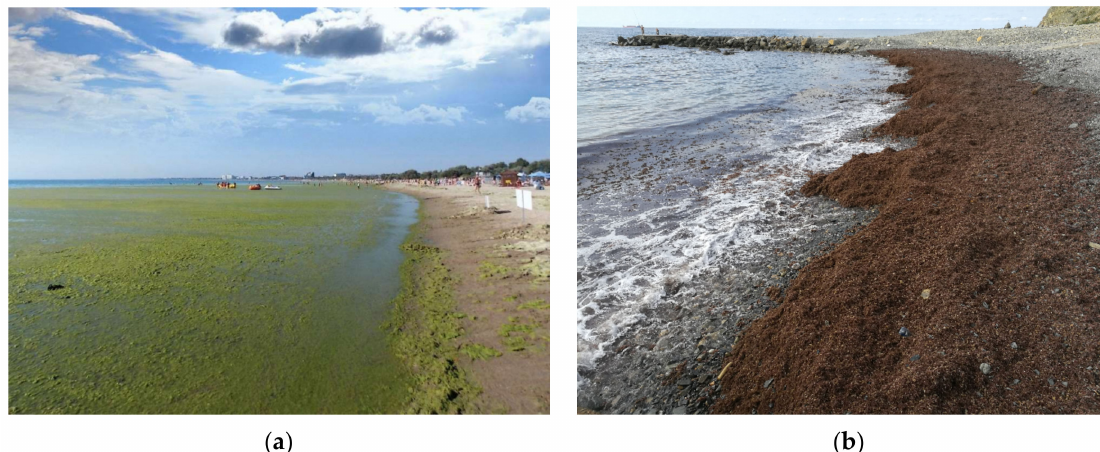
Figure 17. ( a ) Typical summer green algal bloom on beaches of Anapa (https://turvopros.com/kogda-cvetet-more-v-anape, accessed on 16 July 2021); ( b ) concentration of brown algae in water and dead algae washed ashore with a storm